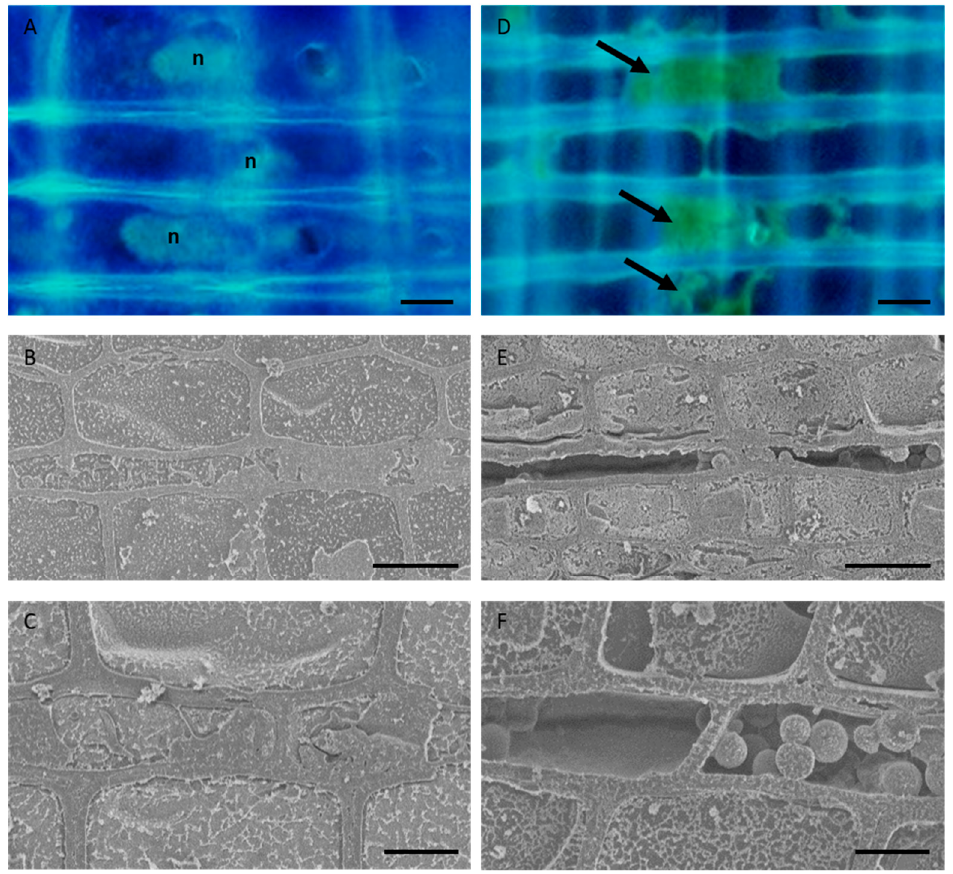
Figure 1. Morphology of the parenchyma cells in the sapwood of normal and freeze–thaw-treated Japanese cedar ( Cryptomeria japonica ) tree trunks. ( A , D ) Fluorescence micrographs of radial sections stained with 4 ′ , 6-diamidino-2-phenylindole (DAPI). ( B , C , E , F ) Cryo-scanning electron micrographs of the transverse plane of frozen-hydrated samples. It can be seen that living parenchyma cells in the normal tree trunk have elliptical nuclei and cellular contents ( A – C ), while the parenchyma cells in the freeze–thaw-treated samples have no or deformed nuclei, contain some autofluorescent material (arrows) in the lumina ( D ), and exhibit dehydration or the accumulation of some broken materials in the cytosol ( E , F ). n, nuclei. Bars, 10 µm.